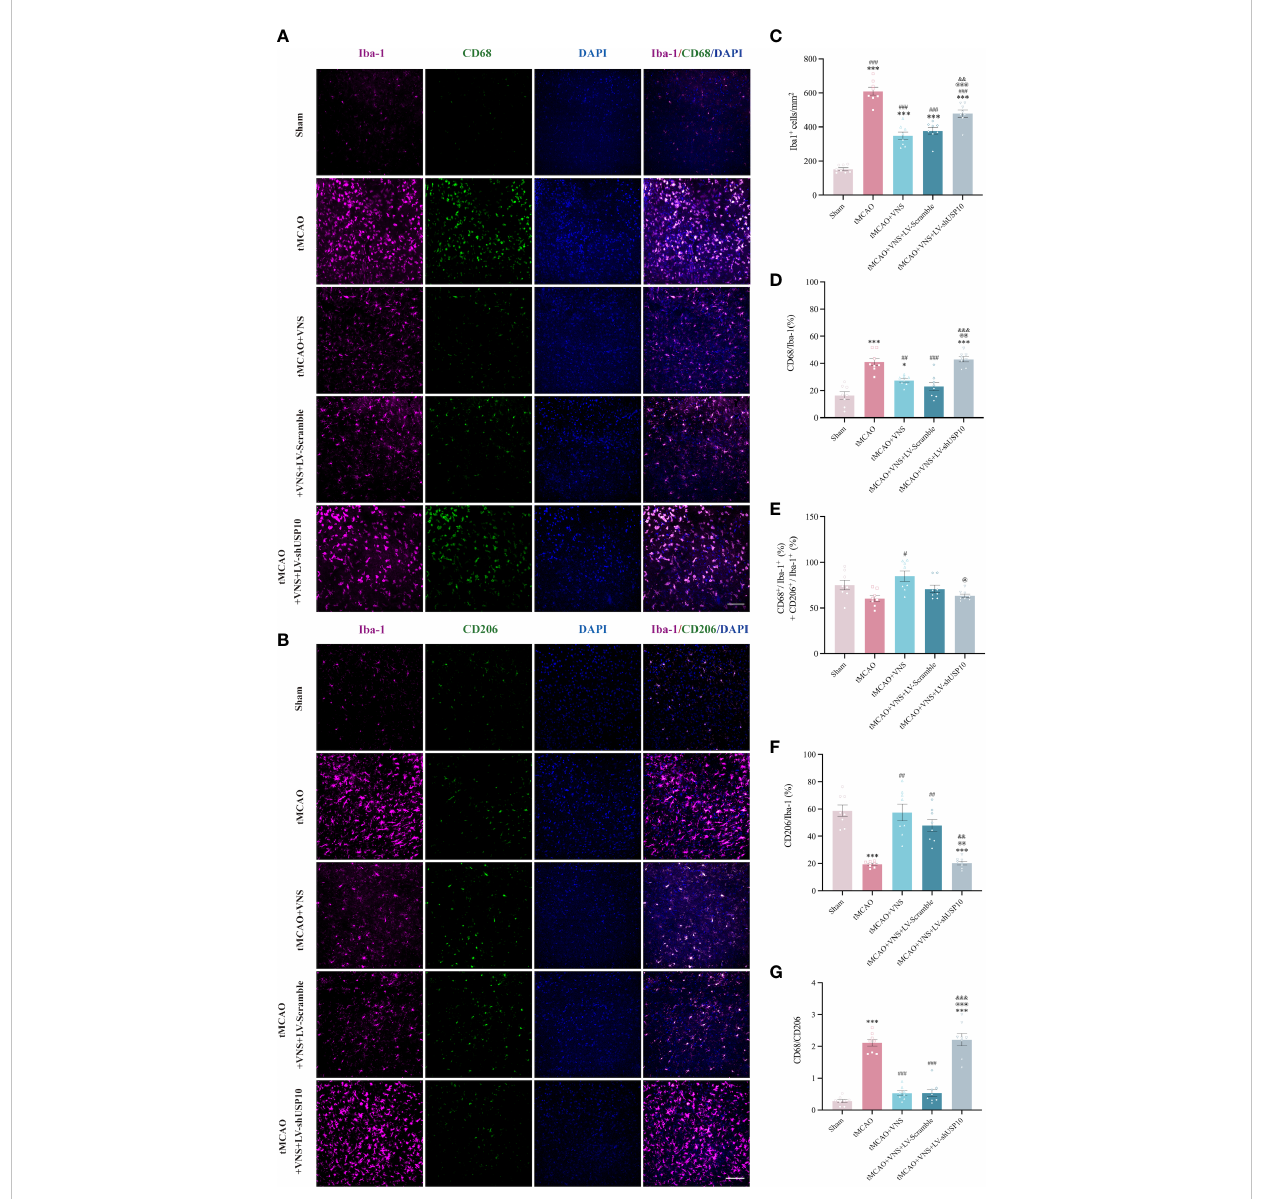
FIGURE 5 Immuno fl uorescence shows USP10 silencing reversed the effect of VNS on microglial activation in ischaemic stroke mice. (A, B) Representative immuno fl uorescence images of CD68 (A) or CD206 (B) expression in Iba-1 + cells. (C) Histogram representation of the quanti fi cation of Iba-1 + cell numbers. (D) The ratio of CD68 + cells to Iba-1 + cells is illustrated as a histogram. (E) Quanti fi cation of the total reactive microglia by the sum of CD68 + + CD206 + cell to Iba-1 + cell ratio. (F) The ratio of CD206 + cells to Iba-1 + cells is illustrated as a histogram. (G) Quanti fi cation of CD68 + / CD206 + ratio. n=8, Scale bar =100 m m. Data are mean ± SEM. ***P<0.001 and *P<0.05 vs. Sham group, ###P<0.001, ##P<0.01, and #P<0.05 vs. tMCAO group. @@@P<0.001, @@P<0.01, and @P<0.05 vs. tMCAO+VNS group. &&&P<0.001 and &&P<0.01 vs. tMCAO+VNS+LV-Scramble